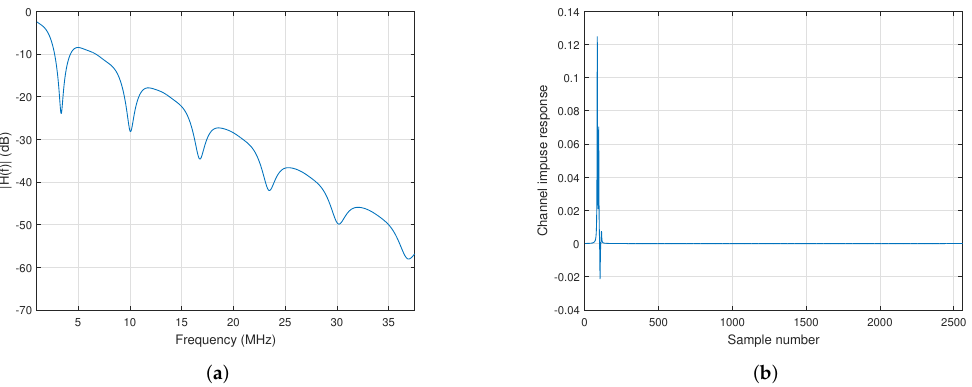
Figure 12. PLC channel: ( a ) magnitude frequency response of the channel; and ( b ) channel impulse response for IoT